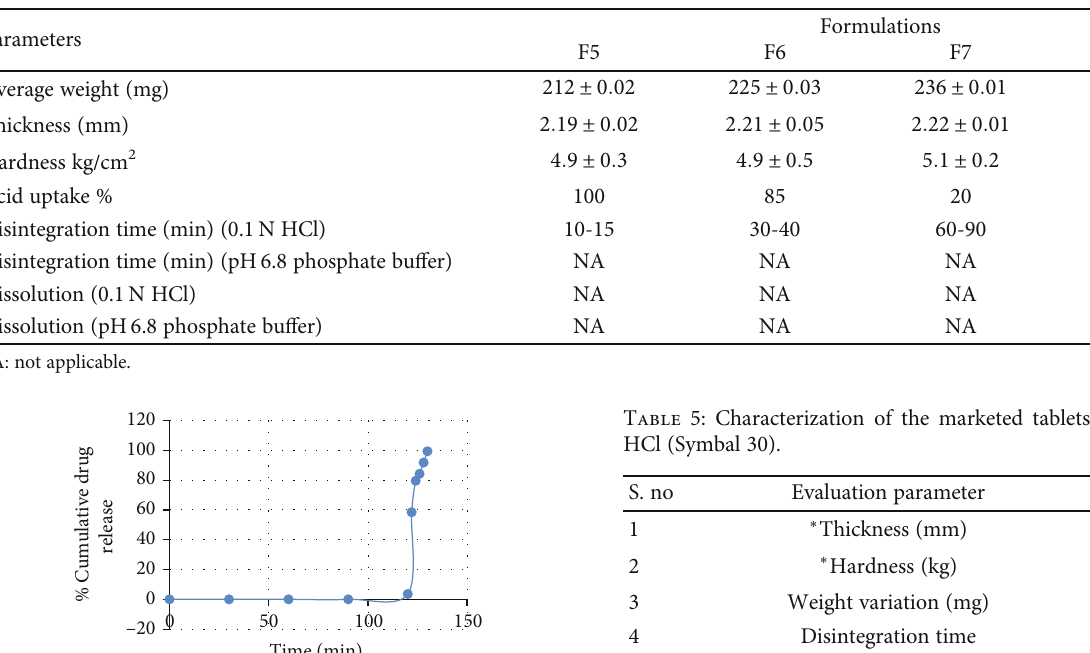
Table 4: Evaluation results of coated formulations F5-F8.